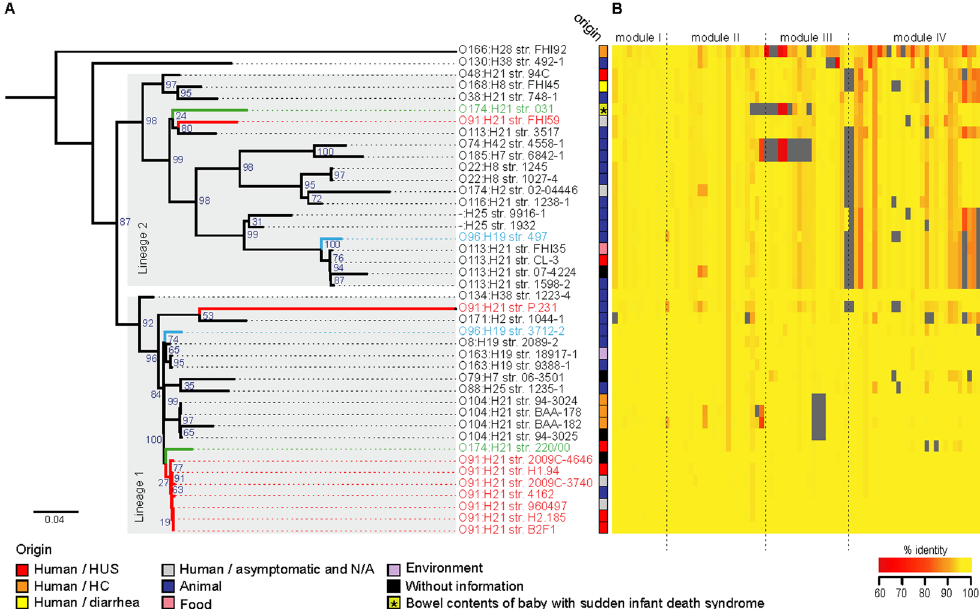
Figure 6. Genetic relationships of the LAA pathogenicity island and conservation of LAA-encoded genes among 42 LEE-negative STEC strains. ( A ) Maximum likelihood phylogenetic tree (midpoint rooted) of LAA sequences based on SNP analysis (677 SNPs within 49,427 positions, which were found in all sequences). The LAA B2F1 sequence was used as a reference. Lineages are indicated by gray shading on the branches. The origin of each isolate is indicated by colored boxes, according to the legend. Bootstrap values are indicated in the tree. Note that both lineages are present in strains belonging to serotypes O91:H21 (highlighted in red), O96:H19 (highlighted in blue) and O174:H21 (highlighted in green). ( B ) Heat map showing the presence, absence and variation of each of the 80 genes located in 42 complete LAA sequences. Each row describes the presence/ absence of one isolate. Presence and variation (nucleotide identity levels, ranging from 60 to 100%) for each gene are indicated by color intensity (red to yellow), as shown in the legend. Absence was defined as an identity and/or gene coverage of less than 60%, and is indicated by the color grey. The LAA B2F1 sequence was used as a reference. The matrix is divided into modules, in order to show the gene variation within each